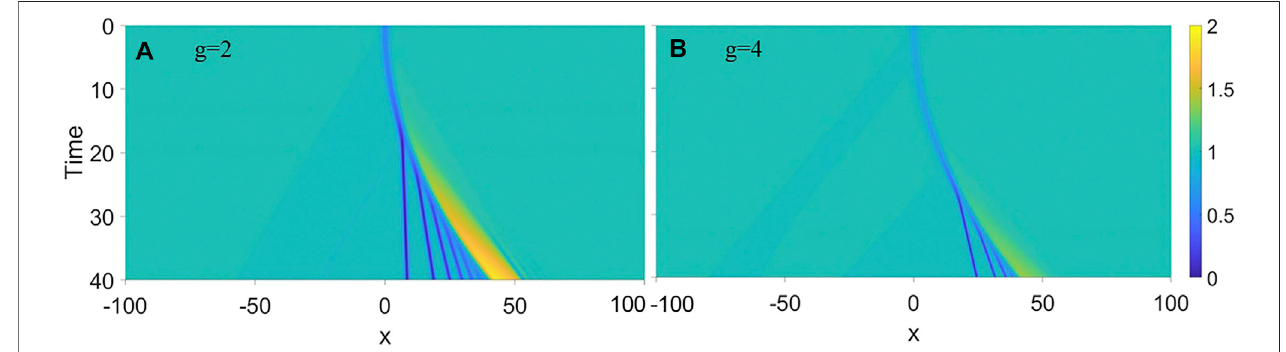
FIGURE5| Solitonic emission fromauniformlyacceleratedobstaclewithzero initialvelocity.The acceleration is fi xed at a (cid:2) 0.05and the obstacle height takes A (cid:2) 1. The nonlinear strength are respectively (A) g (cid:2) 2 and (B) g (cid:2) 4. Dark solitons are emitted only as the obstacle velocity exceeds a critical